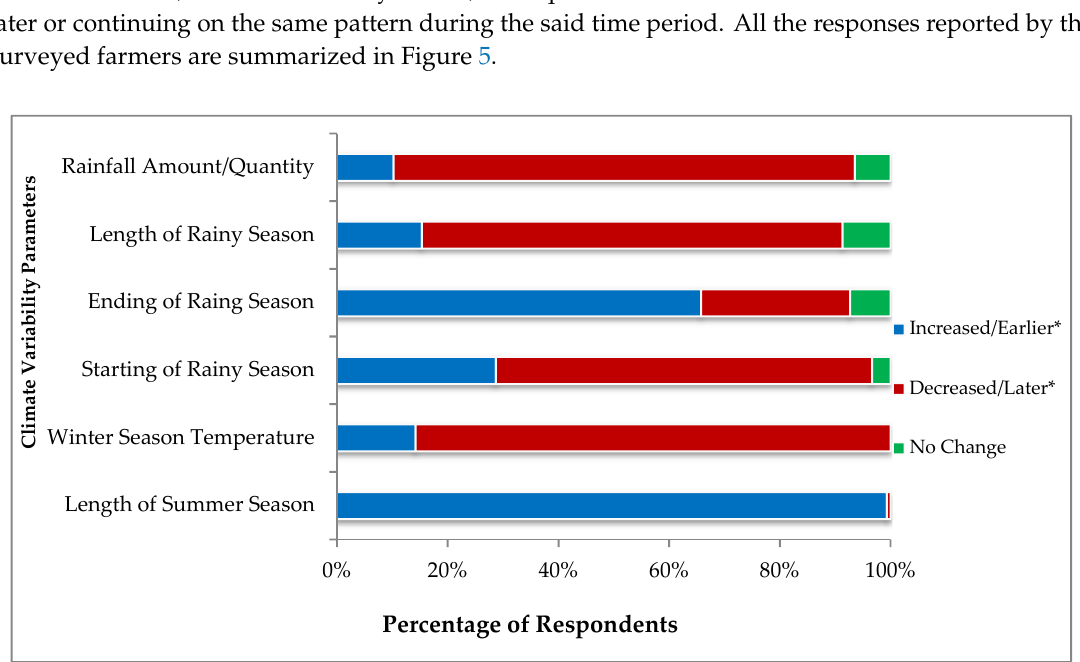
Figure 5. Climatic variability perceived by the dairy farmers